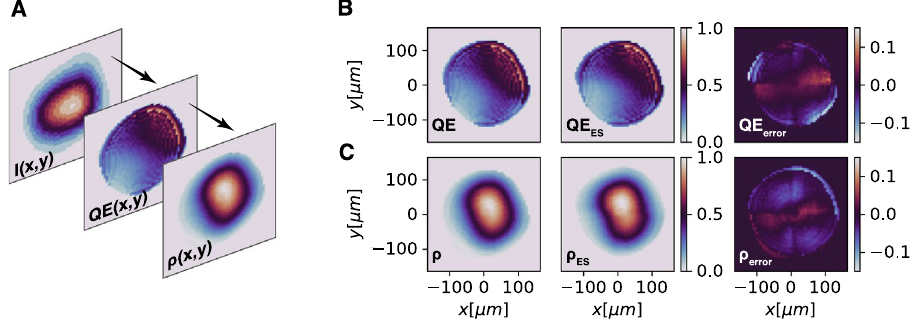
Figure 10. ( A ) Schematic of laser image, quantum efficiency, and the resulting beam density. ( B , C ) Target QE and beam density compared to adaptive